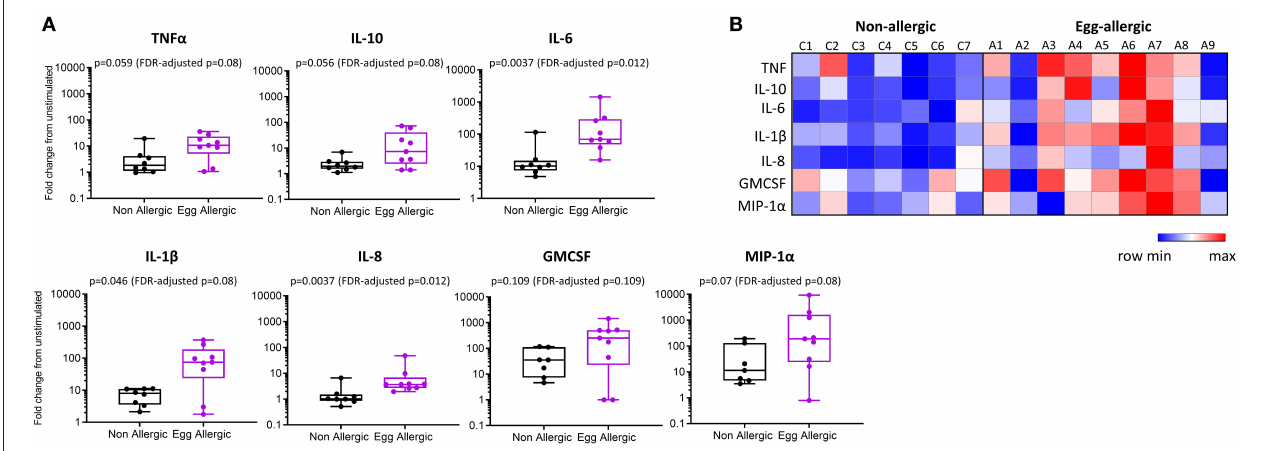
FIGURE 3 | Elevated cytokine production from LPS-stimulated monocytes in egg allergic infants. (A) Monocytes were cultured for 24h with media alone or 1ng/ml LPS. Cytokines were assessed in the cell culture supernatant by cytometric bead array and expressed as fold change from unstimulated in non-allergic ( n = 7, black box plot) and egg allergic ( n = 9, purple box plot) infants. (B) Heatmap showing log2-fold change in cytokine production for all cytokines in each individual using the Morpheus heatmap